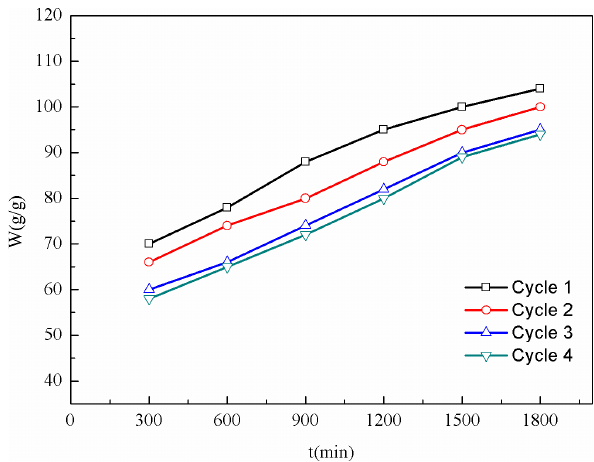
Figure 6: Reflux properties of foam